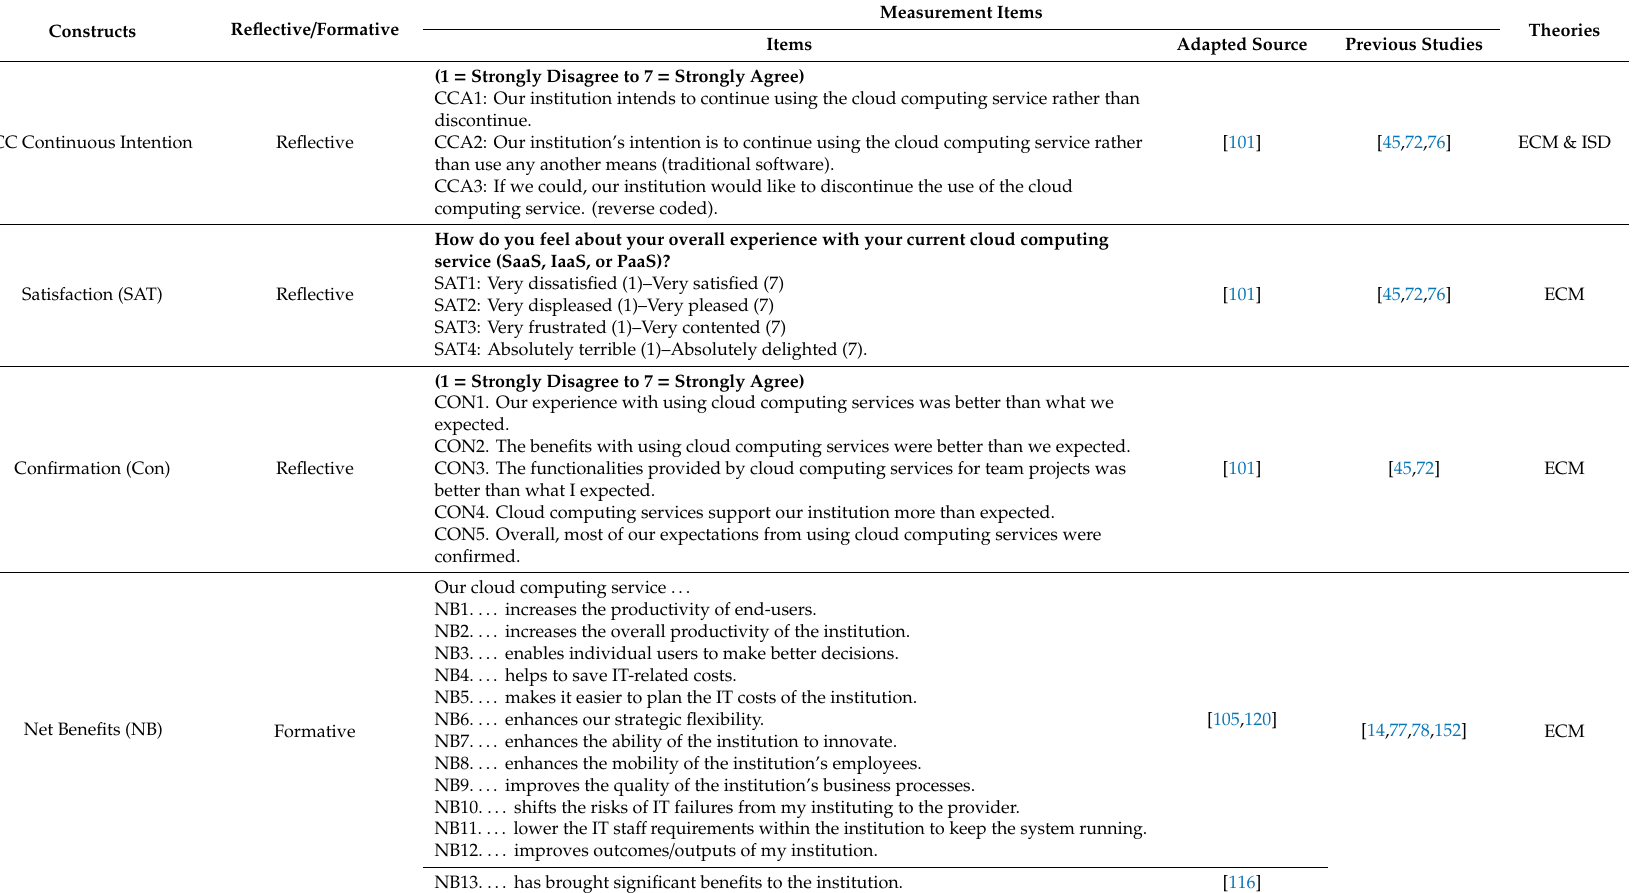
Table A1. Constructs and their Measurement